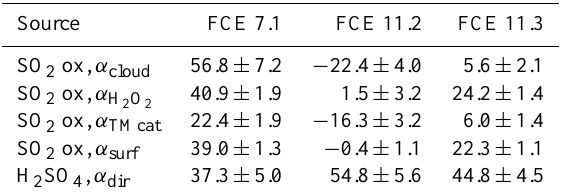
Table 4. δ 34 S values (‰) of the potential sources of sulfate that could be contributed to particles during their passage through an orographic cloud: SO 2 oxidation in the aqueous phase (AQOX) ) and by transition overall in the cloud ( α cloud ), by H 2 O 2 ( α H 2 O 2 metal catalysis ( α TMcat ), SO 2 oxidation on the surface of Sahara dust with no aqueous phase (i.e. on interstitial particles, possibly involving O 3 as described in Harris et al. (2012a); α surf ), and di- rect uptake through DISS/SCAV of sulfuric acid gas and ultrafine particulate ( α dir ).